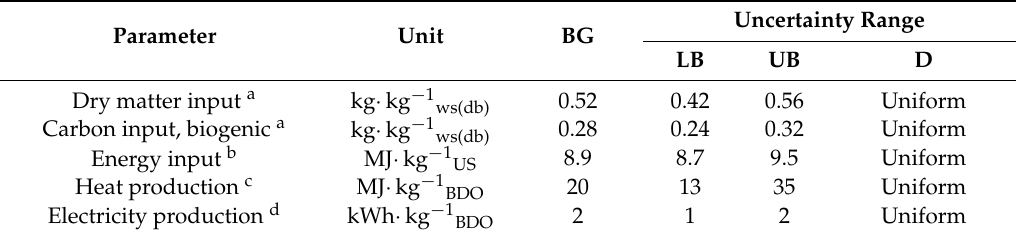
Table 3. Characteristics of unconverted solids. Best guess (BG), Lower and Upper bounds (LB and UB, respectively) and type of applied distribution (D) are